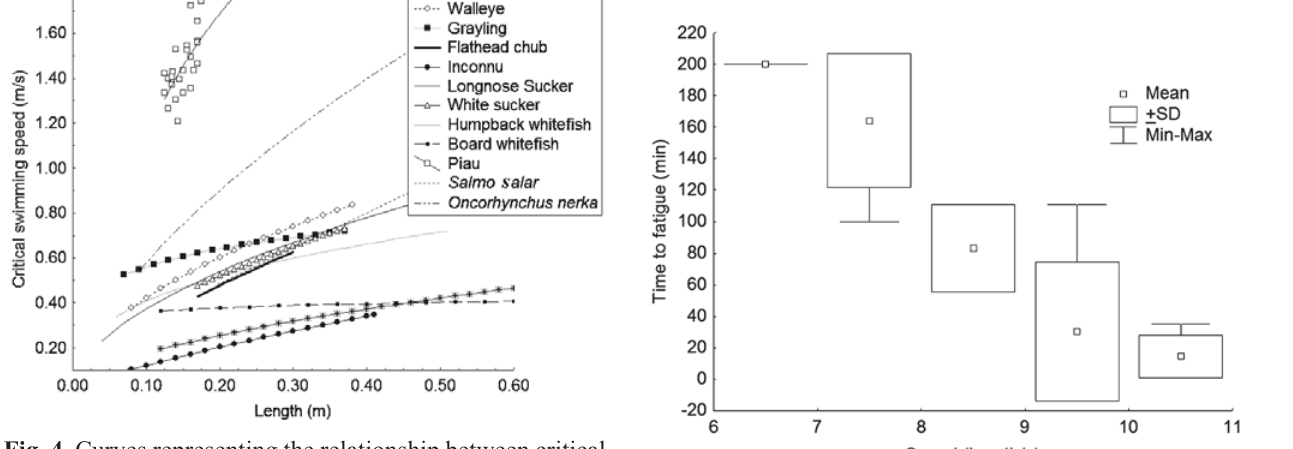
Fig. 4. Curves representing the relationship between critical swimming speed (m/s) and length (m) for the piau (continu- ous line in the squares on the top left of the figure) and some species from the temperate zone. Full names of some species are given in Table 2).